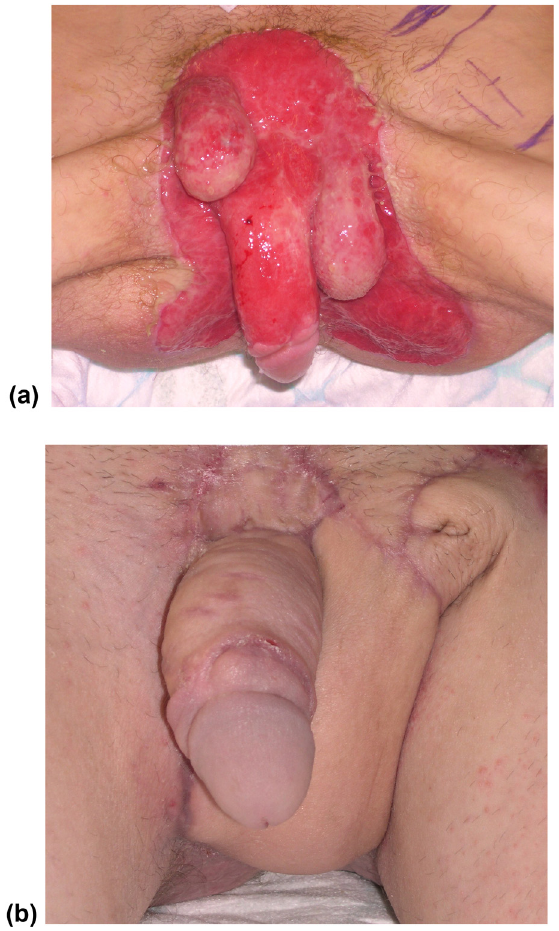
Figure 2: ( a ) Complete scrotum removal, right testicle retraction, and loss of substance of the pubic and penile region in a 45 - year - old patient. ( b ) Reconstruction of the scrotum with inguinal fl ap. Reconstruction of the penis with skin graft from the inner face of the arm. Reconstruction of the perineum with a meshed